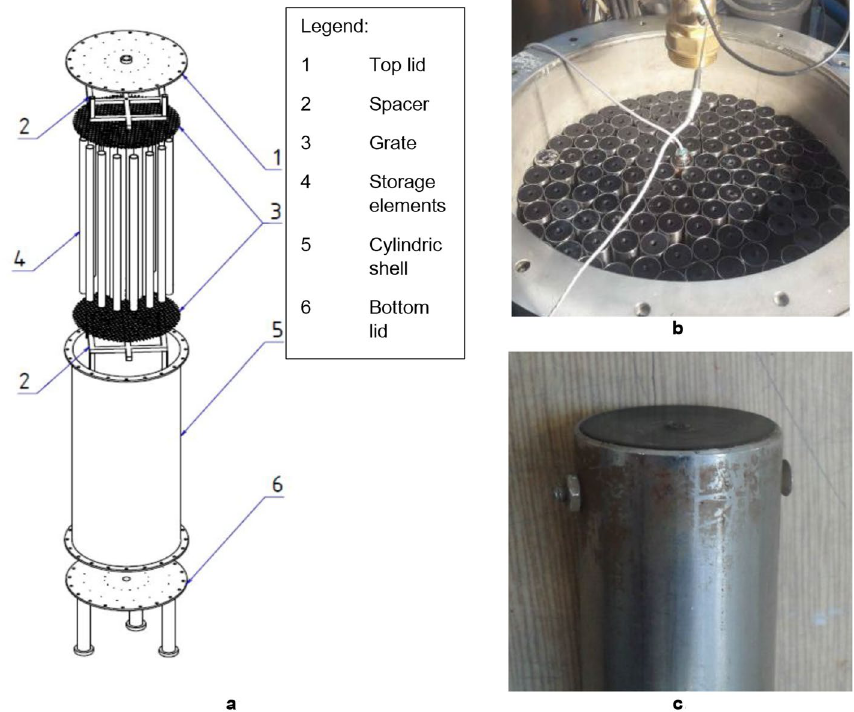
Figure 3. ( a ) The exploded diagram of an experimental PCM heat storage system. ( b ) The storage filled with cylindrical capsules. The capsule with PCM temperature measurement visible in the centre of the tank ( c ) The detail of a cylindrical capsule cap. Some of the caps did not remain tight after several cycles.